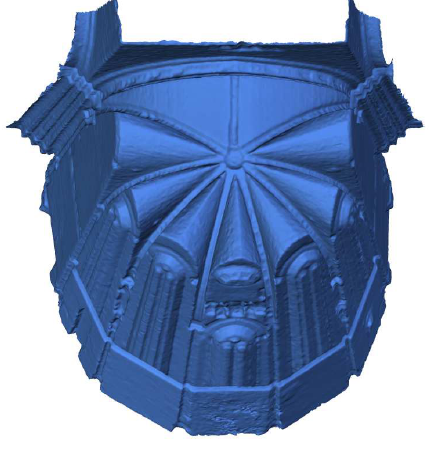
Figure 6. Mesh view with no texture (635.932